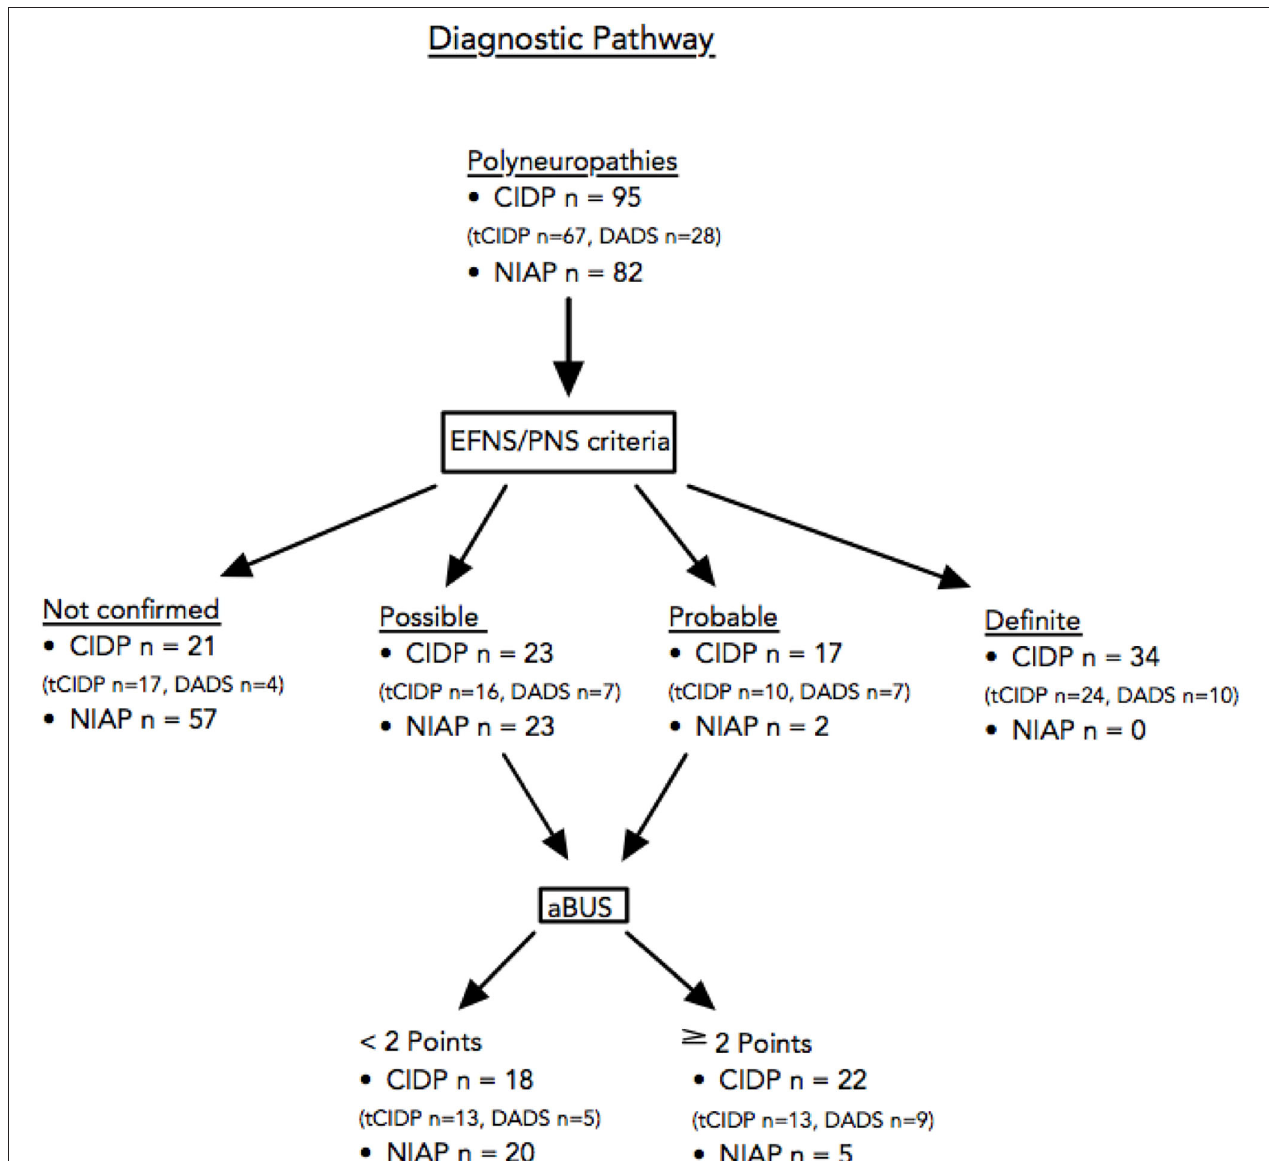
FIGURE 2 | Diagnostic pathway using ultrasound in patients with possible and probable CIDP diagnosis according to electrophysiological EFNS/PNS criteria (2). CIDP, chronic inflammatory demyelinating polyneuropathy; EFNS/PNS, European Federation of Neurological Societies/Peripheral Nerve Society.